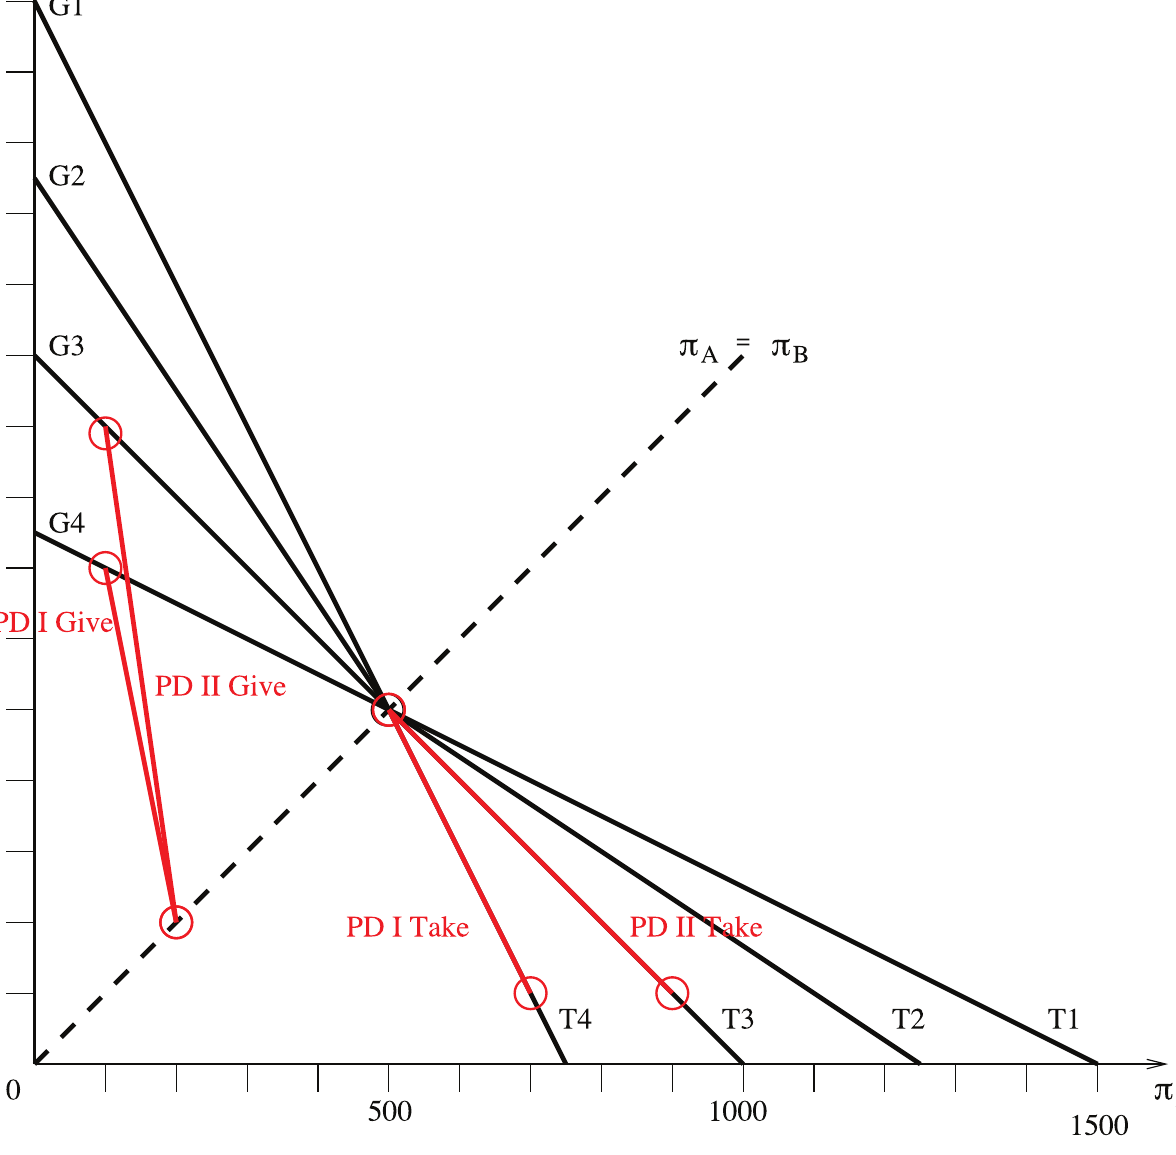
Fig 2. Budget lines in modified dictator and sequential prisoner’s dilemma games.